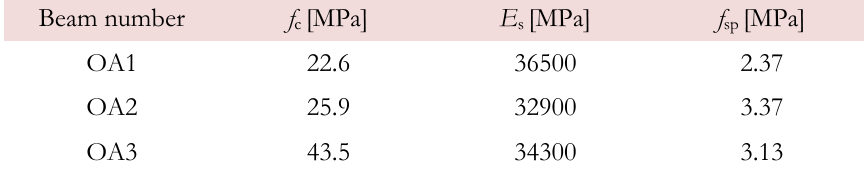
Table 3: Material properties of